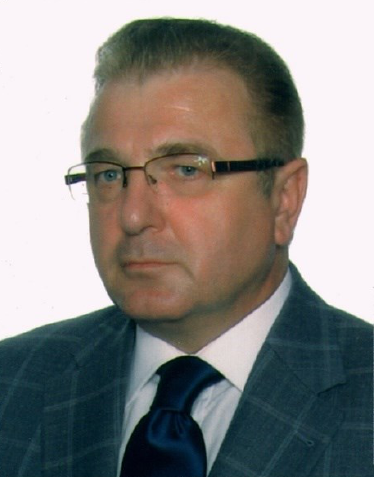
Figure 8. Andrzej K. Siwicki received his Ph.D. degree from the National Inland